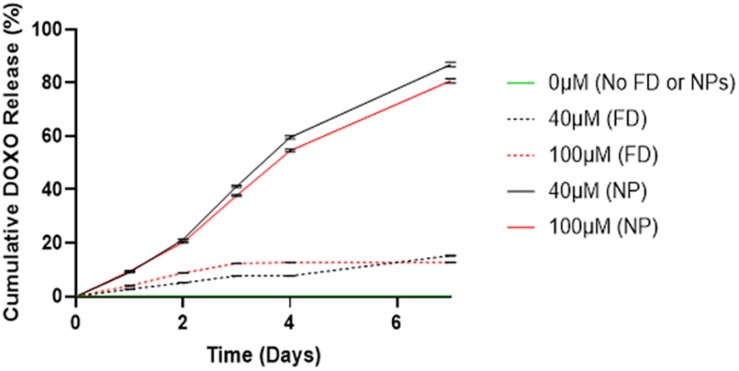
Drug release profiles of DOXO from bone cements (40/60) containing no DOXO (0 μM), free DOXO (40 μM and 100 μM) and PLGA-DOXO NPs (40 μM and 100 μM), into PBS after 7 days incubation at 37°C. Data presented as mean ± standard deviation, (n = 3 replicates).